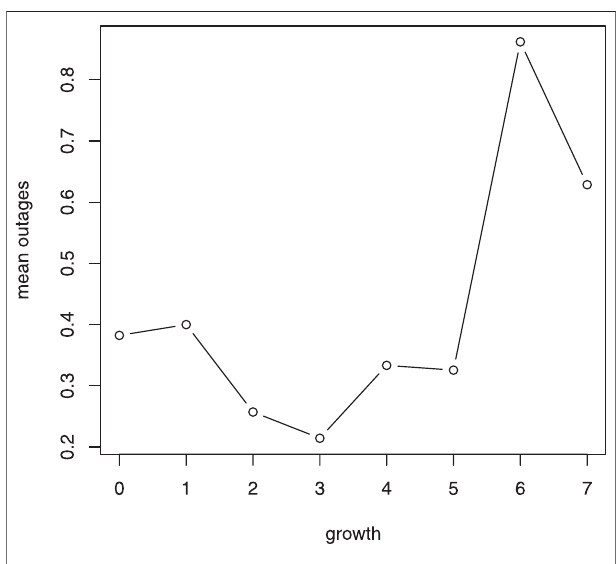
FIGURE 3 | Mean vegetative-caused outages on different growth years.